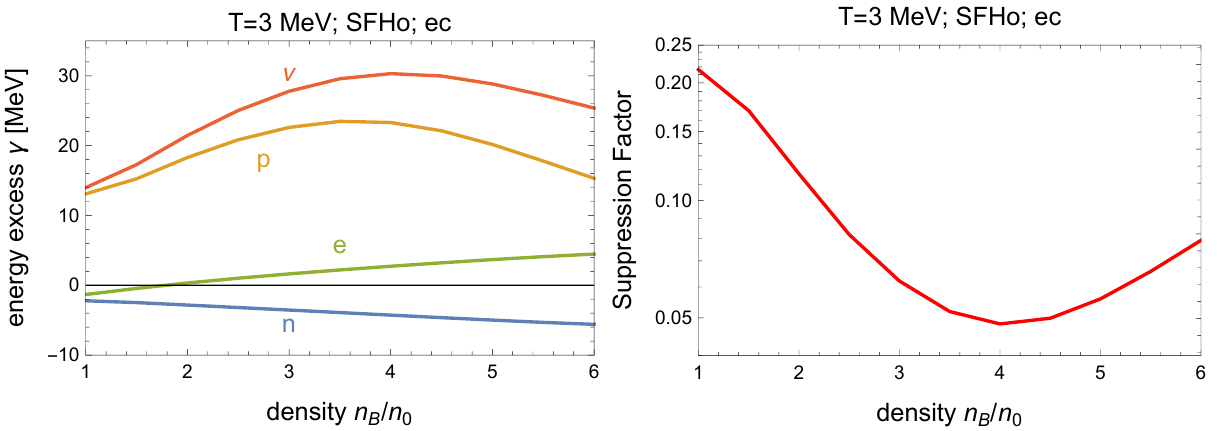
Figure 14. The optimal kinematics for electron capture at T = 3MeV for SFHo, obtained by maximizing the Fermi-Dirac products. The suppression factor, e −| γ p | / T e −| γ e | Θ ( γ e ) / T e −| γ n | Θ ( − γ n ) / T , is dominated by the difficulty of finding a proton above its Fermi